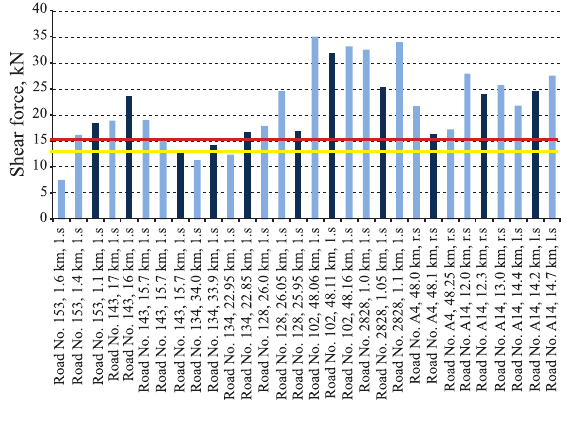
Fig. 5. Distribution of the bonding force between the upper and lower asphalt layers depending on the sampling location: